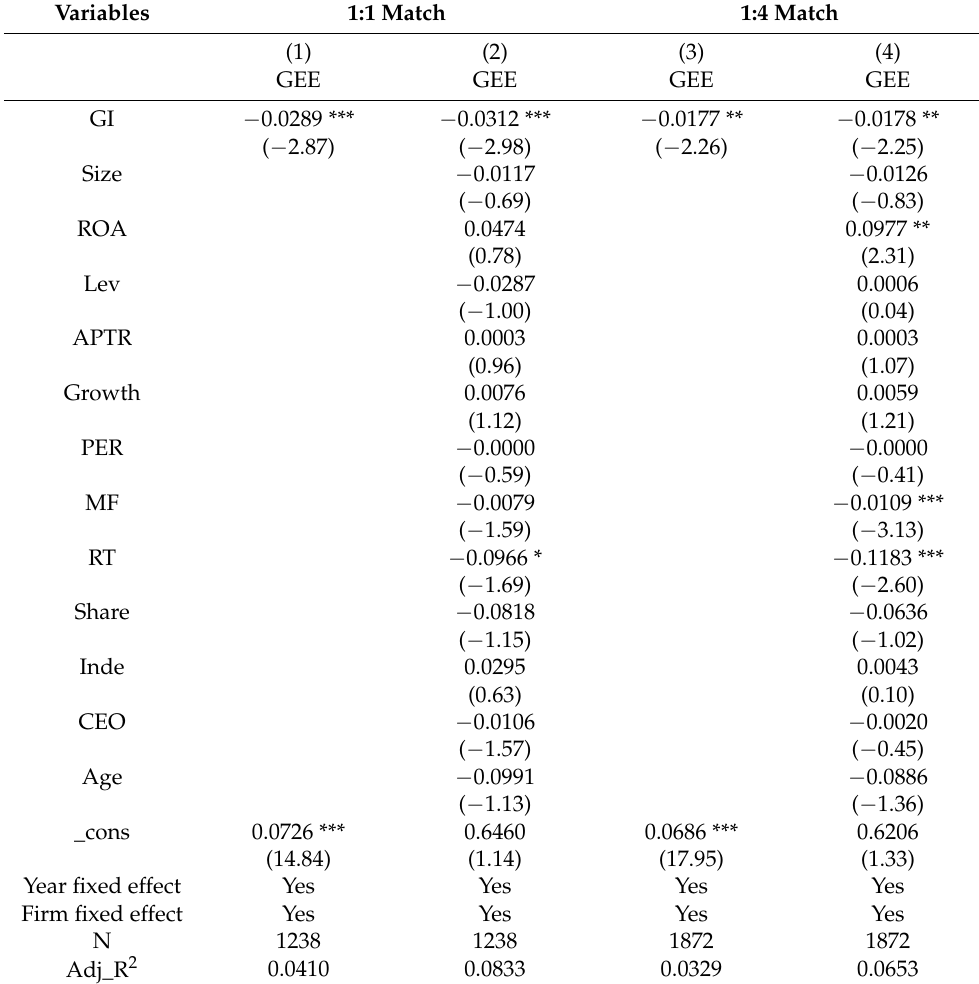
Table A8. Green innovation and green economic efficiency: PSM (Full version of Table 3). Variables